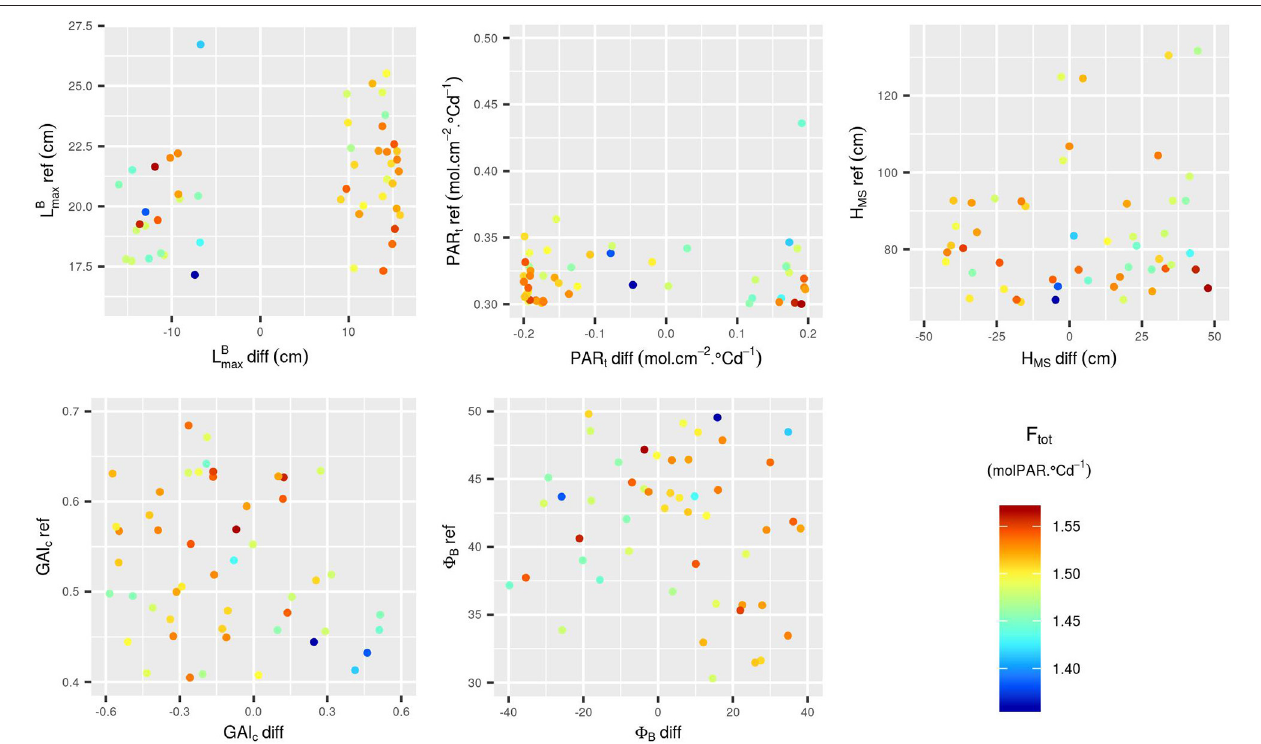
FIGURE 8 | Input parameter values for the 50 points added to the design via EGO. The points are colored according to the corresponding value of F tot . The additional points were selected in the whole range of variation of the 10 input parameters.